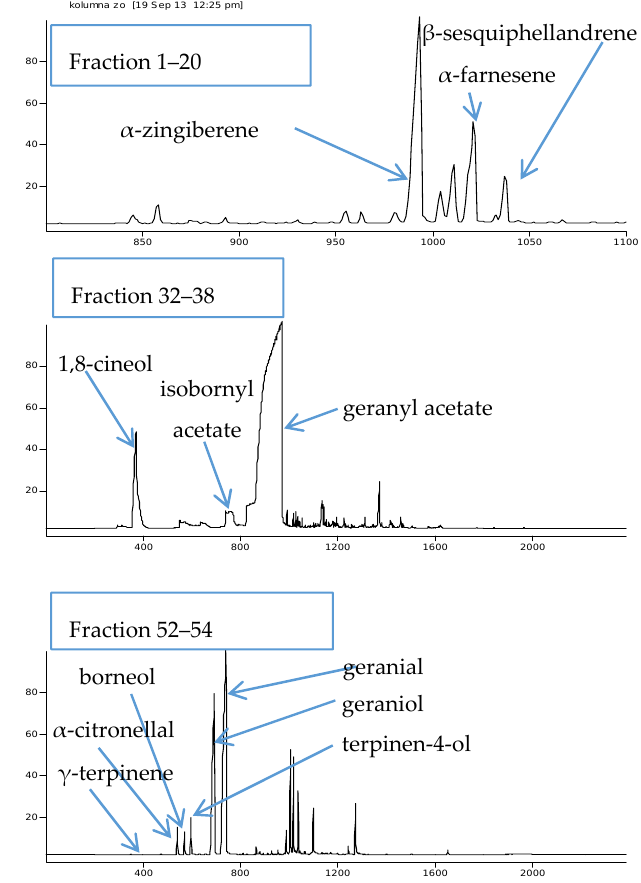
Figure 2. The composition of three most active collective fractions from column 1 determined by GC-MS analysis (y axis—number of scan, x axis—intensity of the peak in relation to the most abundant one determined as 100%).